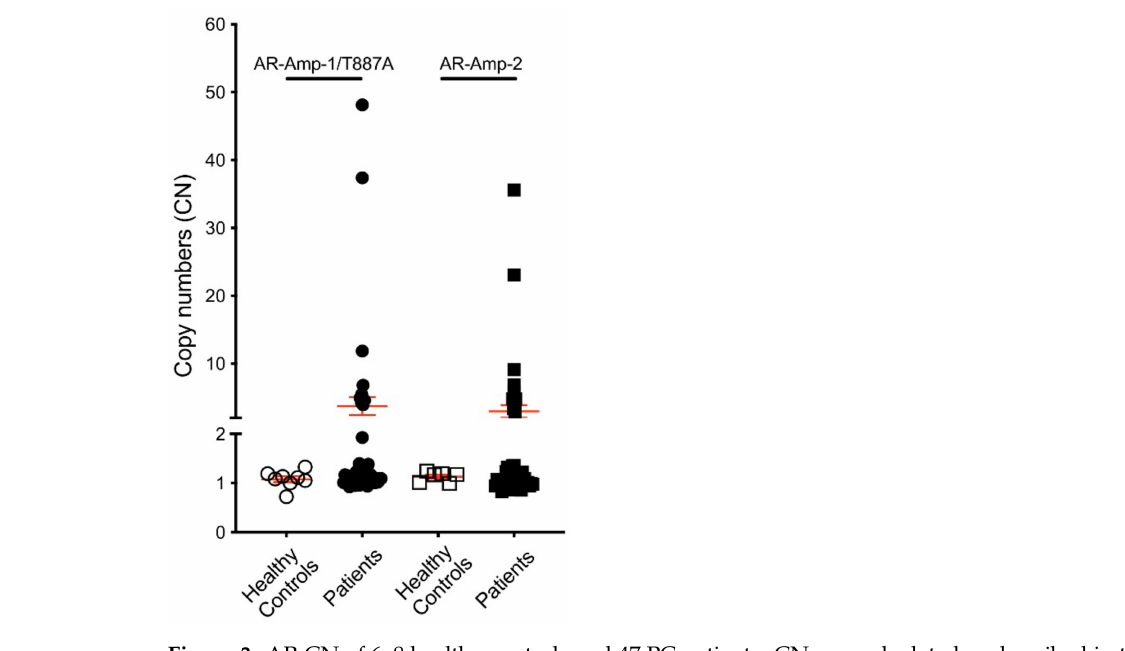
Figure 3. AR CN of 6–8 healthy controls and 47 PC patients. CN was calculated as described in the Materials and Methods section. Circles: AR-Amp-1/T877A; squares: AR-Amp-2; open circles/squares: healthy blood donors; solid circles/squares: patients; error bars in red: mean ± SEM.